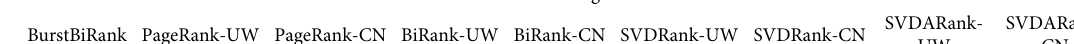
Table 4: Top-20 developer